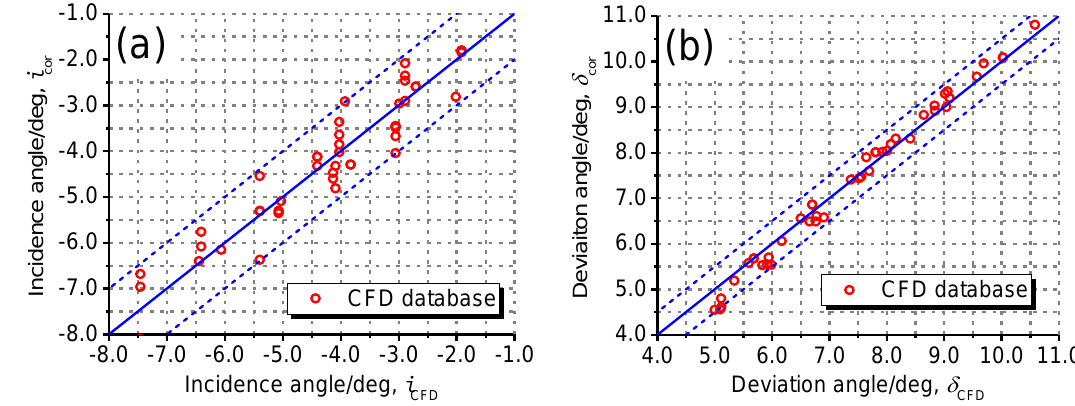
Figure 12. Comparisons between the results predicted by using basic correlations and the CFD database for ( a ) incidence and ( b ) deviation angles.